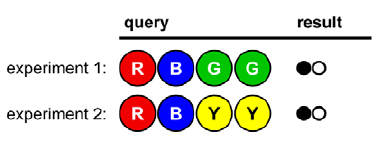
Figure 3. A game opening illustrating Lesson 2.